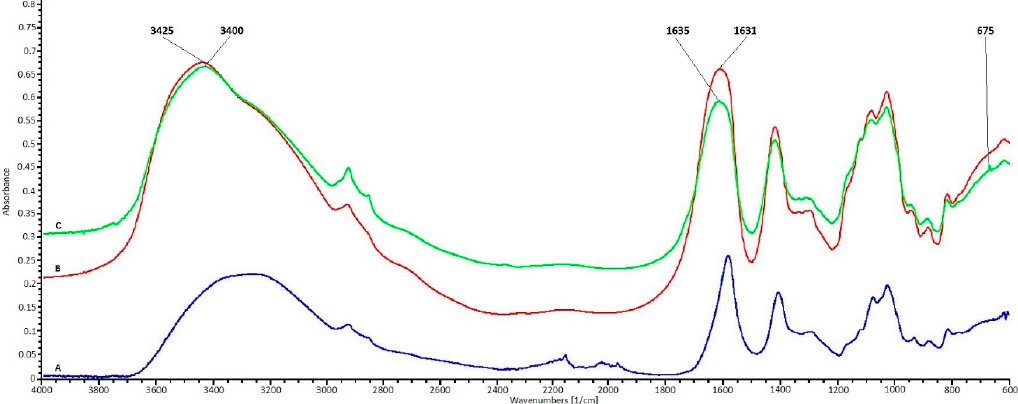
Figure 1. FTIR spectrum of alginate fibers. ( A ) Fibers without nano additive, ( B ) fibers with 2% nano additive ZnO, and ( C ) fibers with 7% nano additive TiO 2 .